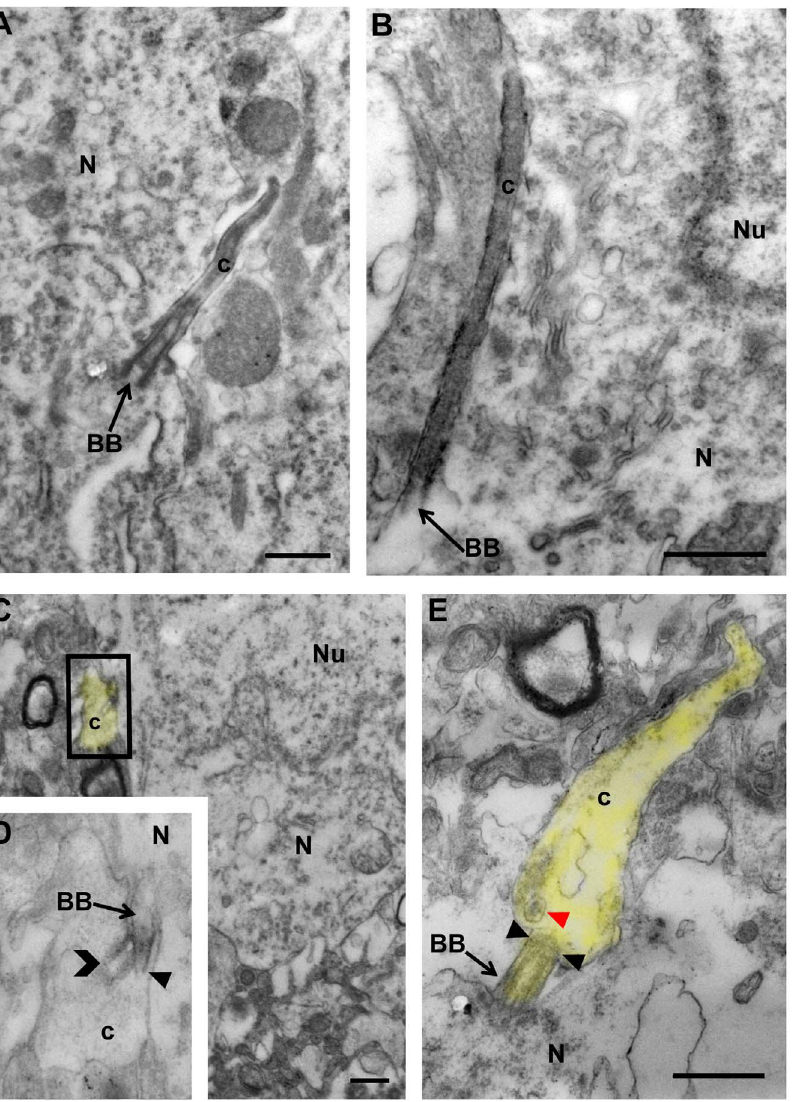
Figure 2. Transmission electron microscopic images of PNC in amygdala of WT (A & B) and Bbs4 -/- mice (C & E). Note the intact basal bodies associated with neurons in WT and Bbs4 -/- mice and abnormal cilia starting from basal bodies in C & E compared to healthy PNC with microtubules in A & B. The insert (D) is a higher magnification image of the area incorporated in the rectangle on (C). The yellow highlights the shape of PNC in Bbs4 -/- lateral amygdala. The solid arrowheads in D and E point to the ciliary transition zones; open head arrow points to the broken axoneme; red arrow head points to the spherical inclusion bodies. The yellow highlights the shape of PNC in Bbs4 -/- lateral amygdala. The data was collected from three WT and five Bbs4 -/- mice. BB – basal bodies; c – cilium; N -neuron; Nu – nucleus; arrows point to BB. Scale bars: 0.5 m m for A-E.